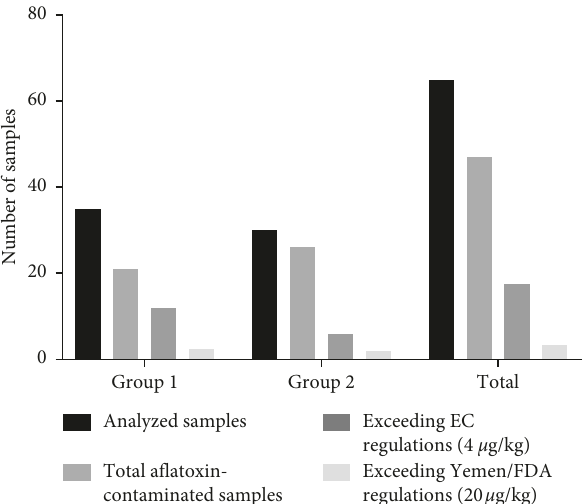
Figure 2: Total aflatoxin contamination in soybean samples (total samples, group 1, and group